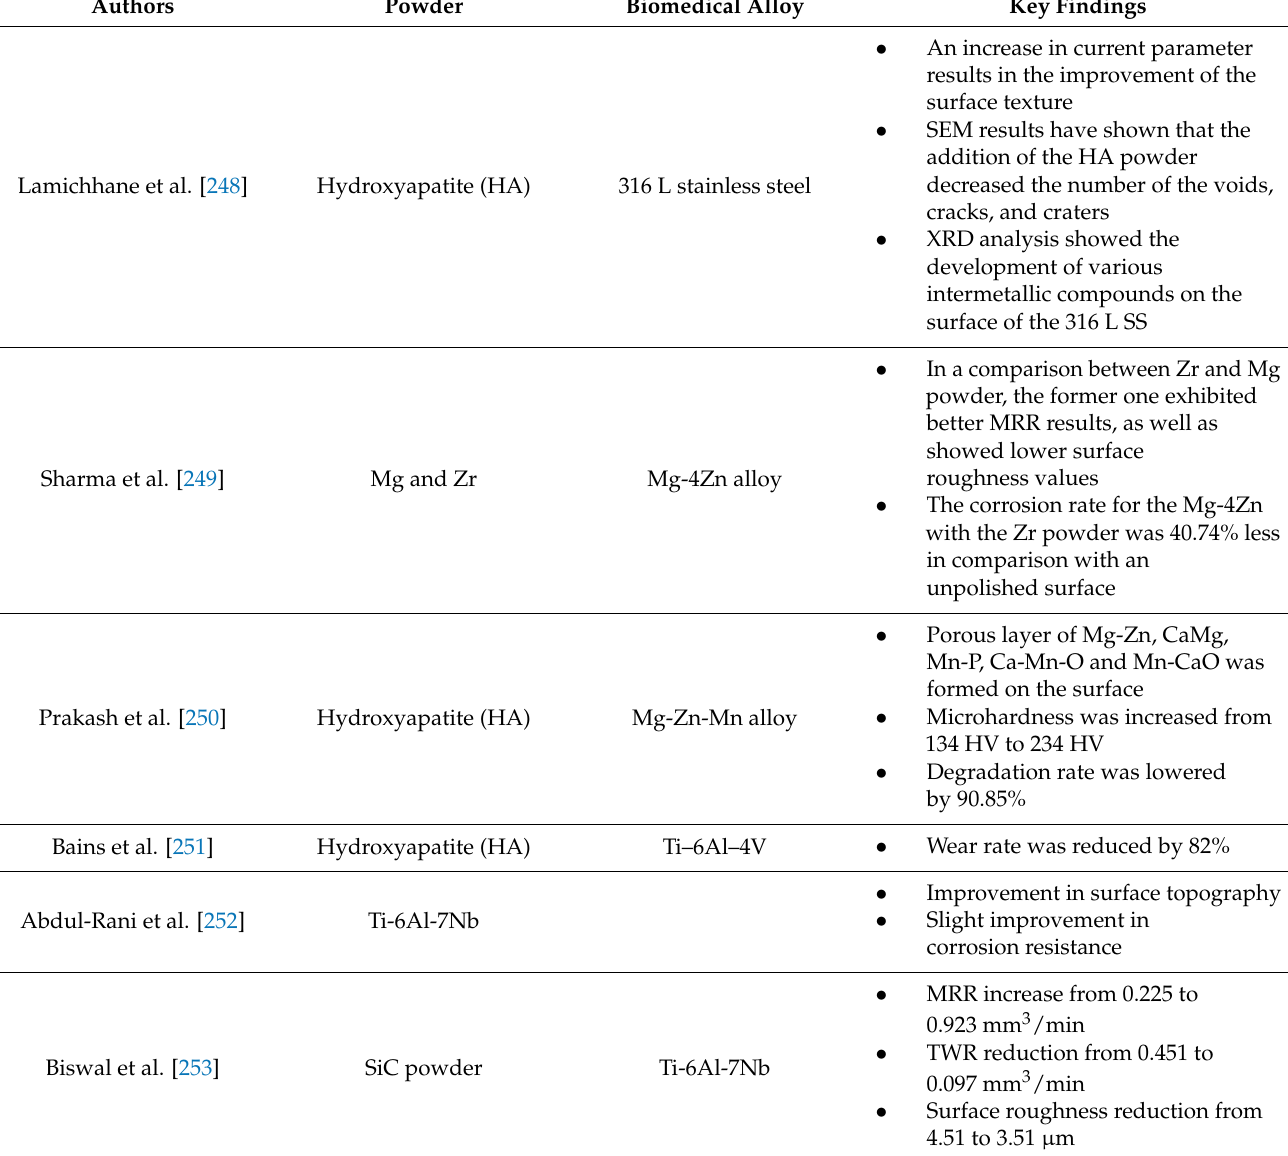
Table 18. PMEDM for surface